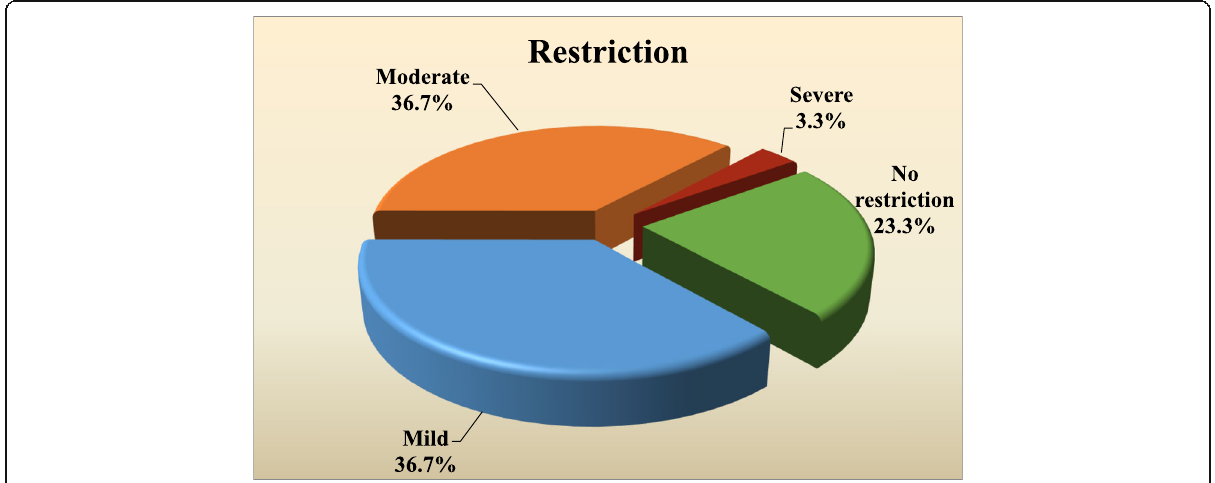
Fig. 7 Percentage of restriction in systemic sclerosis patients in the study according to spirometry values